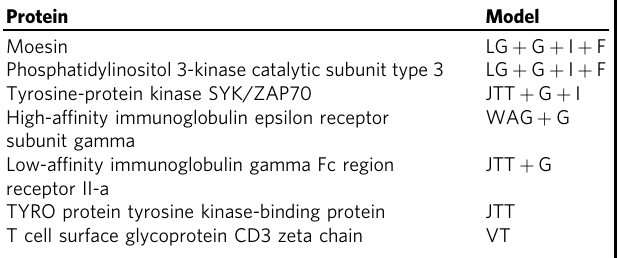
Fig. 7 Potential evolutionary implications of PIP2-based signaling in modern immune receptor-based phagocytosis. Phylogenetic trees of Fc γ receptor II family proteins (Fcgr2), Fc ε receptor γ subunit (Fcer1g), DAP12 (Tyrobp), CD3 ζ chain, Moesin, Syk family proteins (ZAP70 and Syk), and PI3 kinase catalytic subunit (PI3K) are shown. On top of the fi gure, the time axis is shown in the unit of million years. For each tree, the time axis is shown on the bottom, and is aligned to the time axis on the top. The species divergence times from published studies are used. For each tree, the vertical axis on the left shows the number of substitution per site compared to the amino acid sequence of the homolog in Homo sapiens , so the slope of each branch represents amino acid substitution rate. The gray column indicates the time interval of two rounds of whole-genome duplication (WGD) during the evolution of common ancestors of chordates (1R) and vertebrates (2R). The dark gray bar on top of the fi gure indicates the time interval of emergence of RAG1 and RAG2 (not the RAG invasion